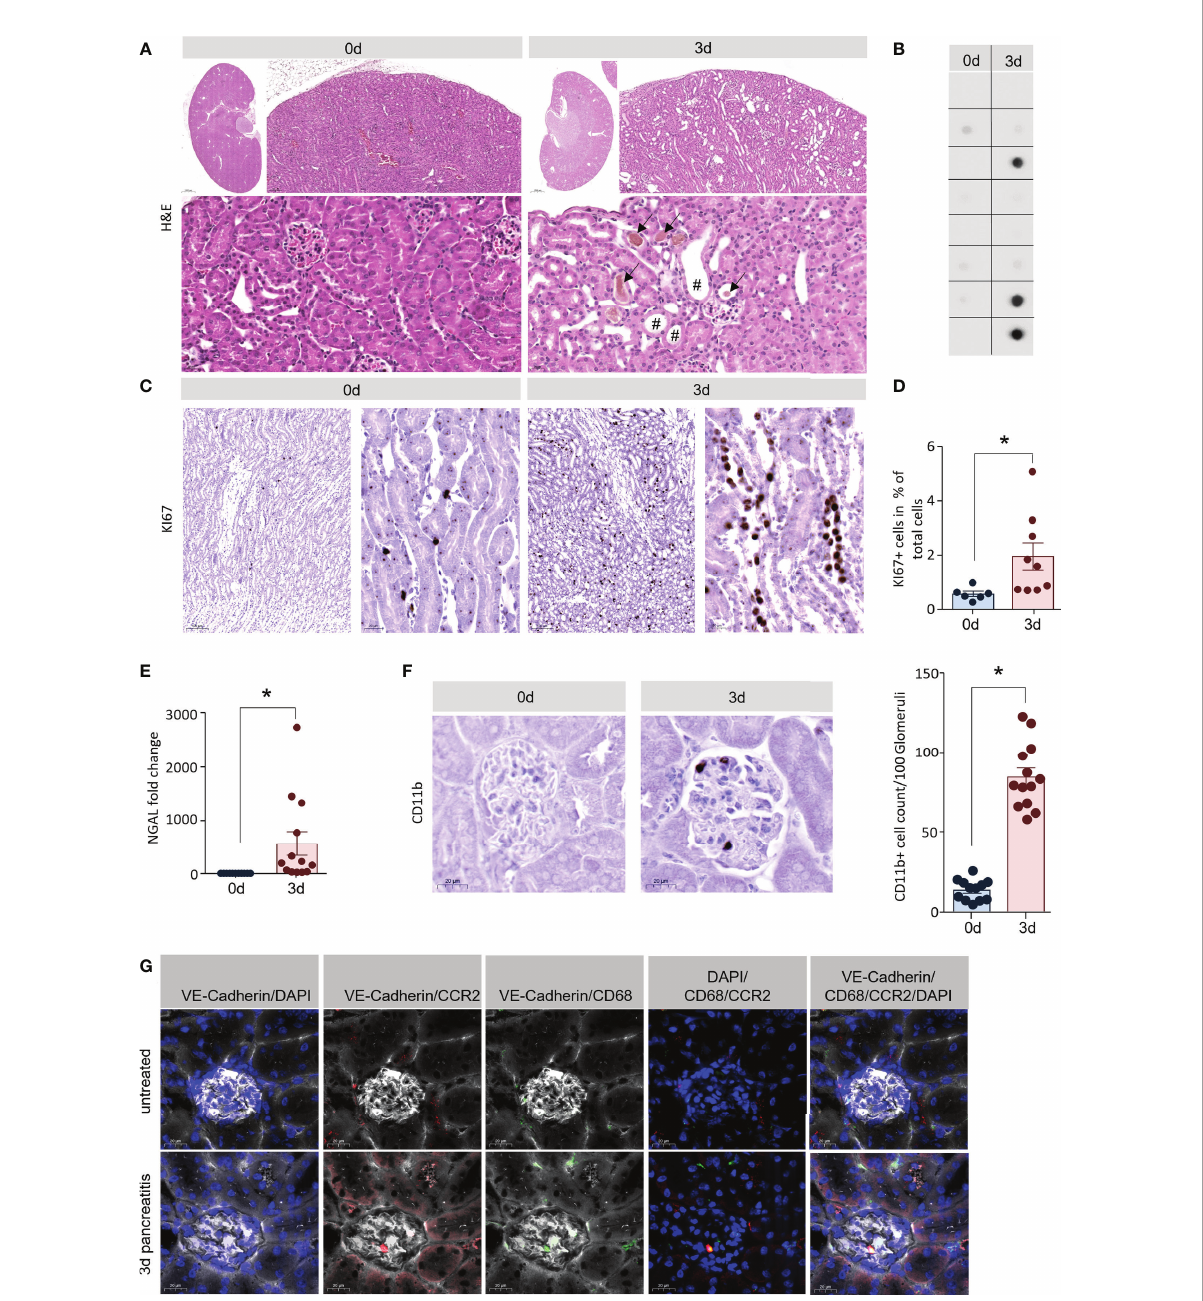
FIGURE 2 Acute kidney injury in the model of AP. (A) H&E staining of kidney sections showed also clear signs of early tissue damage 3d after induction of pancreatitis: tubular dilatation (rhomb) and hyaline casts (black arrows). (B) Dot blot analysis of cystatin C in urine samples of mice (n=8/8 for controls and SAP) were positive in 3 out of 8 mice with SAP. (C, D) Tubular dilatation was associated with increased cell proliferation (shown by Ki67 positive nuclei). Quanti fi cation of Ki67 staining showed a signi fi cant increase of tubular cell proliferation. (E) RT-qPCR analysis of Ngal in kidney tissue showed a signi fi cant increase 3d after onset of pancreatitis. (F) Kidney sections we observed a signi fi cant increase of CD11b + cells in the glomerulus. (G) Labelling of CCR2 (red), VE-Cadherin (white) and CD68 (green) suggest that these cells are monocytes. All graphs represent 6 or more animals per group. Statistically signi fi cant differences were, tested by unpaired student`s t-test for independent samples and signi fi cance levels of p<0.05 are marked by an